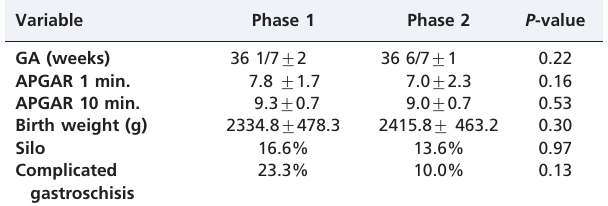
Table 1 - Gestational age (GA), APGAR scores at 1 and 10 minutes, birth weight (mean ¡ sd), occurrence of complicated gastroschisis and silo usage in both phases of the study.